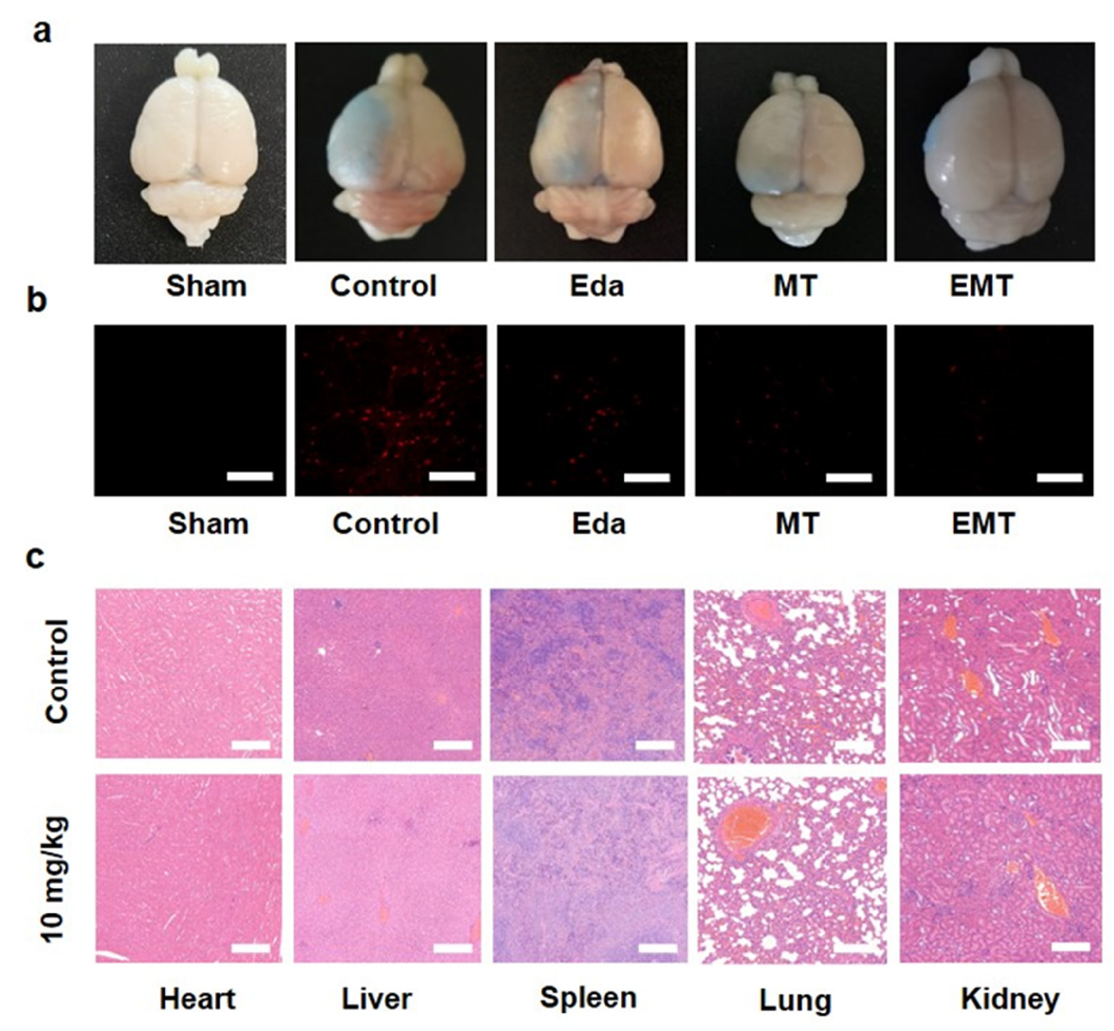
Figure 6. EB extravasation assays and safety evaluation. ( a ). Representative digital photographs of the whole brain stained by infiltrating EB ( b ). Corresponding typical confocal images (scale bar = 50 µm) of the brain slices in each group demonstrating red fluorescence of EB under an excitation wavelength of 620 nm. ( c ). Safety evaluation of the EMT nanozyme in vivo: H&E staining of healthy SD rats after intravenous injections of the EMT nanozyme at a dose of 10 mg/kg, including heart, liver, spleen, lung, and kidney (scale bar = 100 µm).